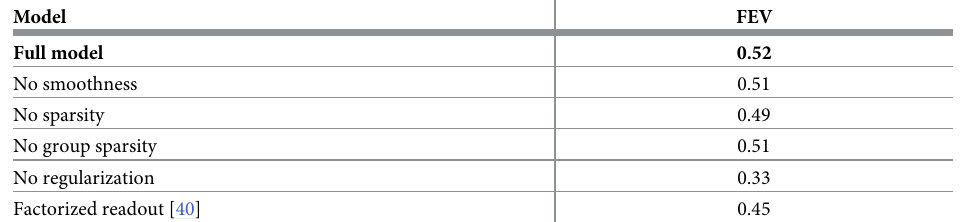
Table 1. Ablation experiments for VGG-based model, removing regularization terms (rows 2–5) and using factor- ized readout weights (row 6, [40]).